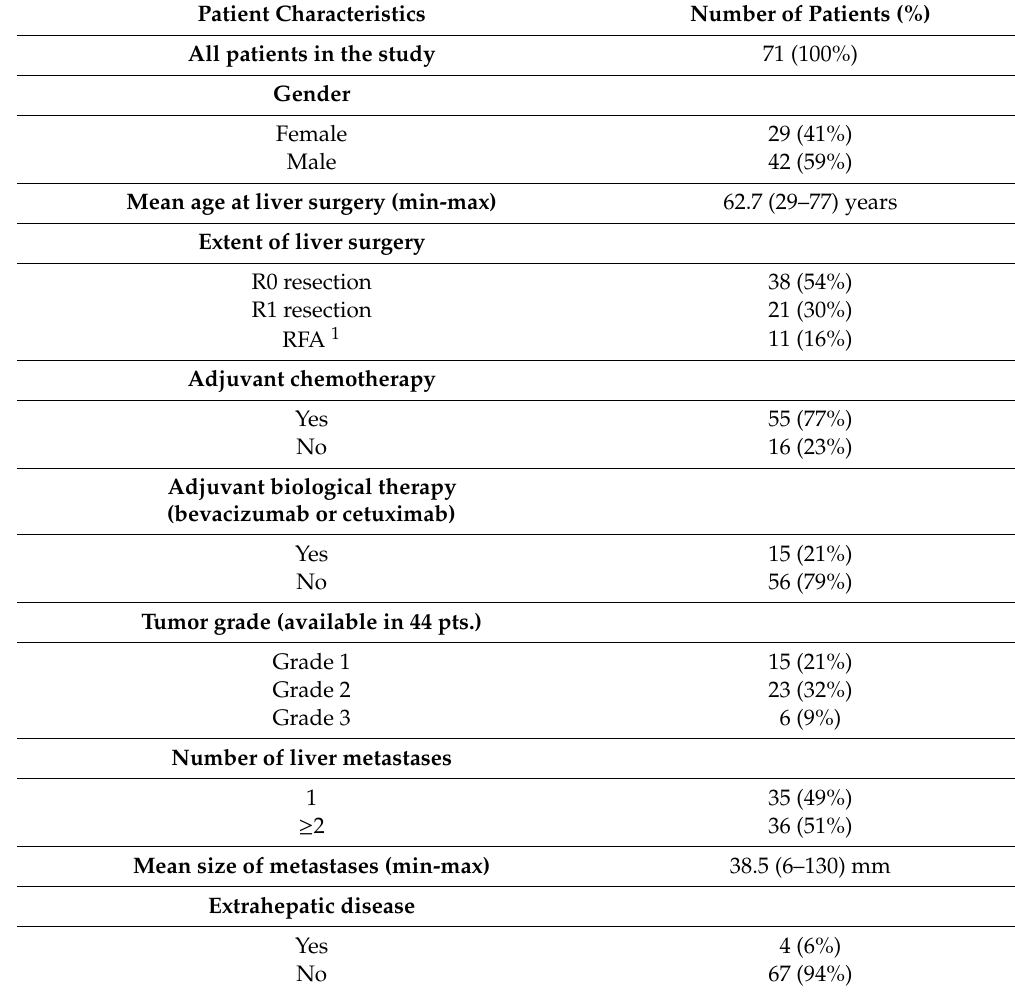
Table 4. Patient